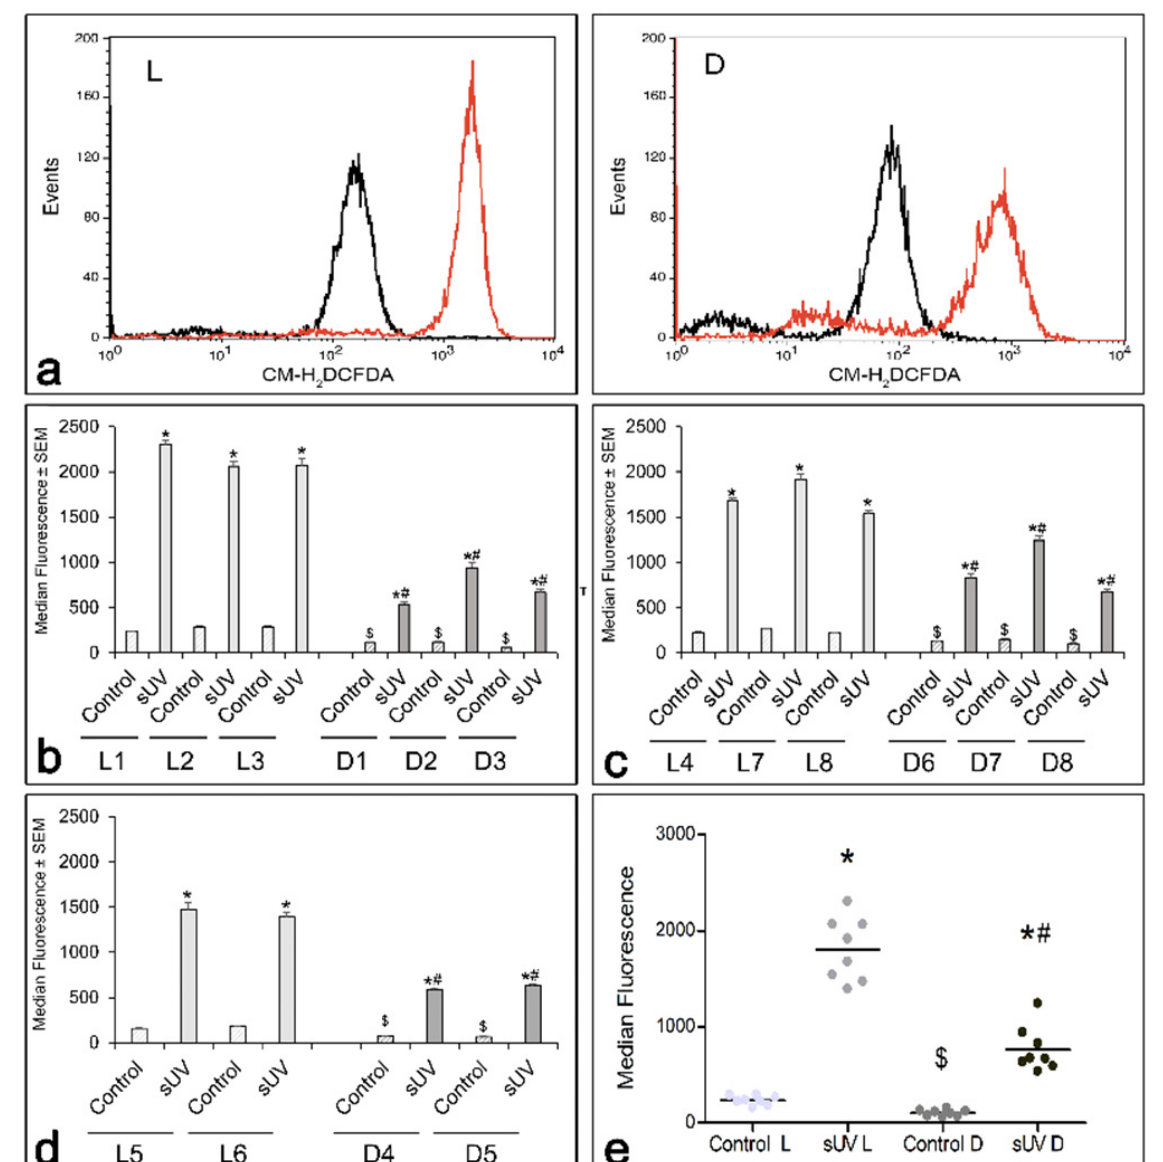
Figure 3. Comparison of basal and 7 J/cm 2 solar UV-induced ROS in 8 L versus 8 D melanocyte cultures. ( a ) Includes representative histograms comparing basal (in black) and solar UV-induced (in red) ROS in L and D melanocytes. ( b – d ) Represent the results of 3 independent experiments, as determined after loading with CM-H 2 DCFDA and a flow cytometry analysis, as described in Materials and Methods. ( e ) Dot plot representing the cumulative data in ( b – d ). * = Significantly different from their respective control groups ( p < 0.0001). $ = Significantly different from the control L groups ( p < 0.0001). # = Significantly different from all irradiated L groups and p < 0.0001.